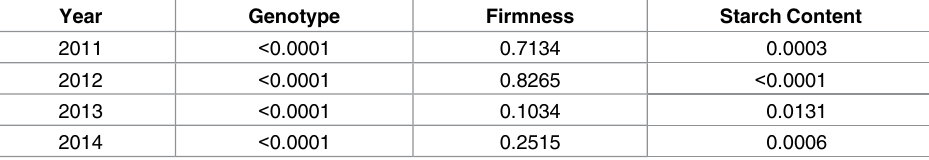
Table 2. Probability ( P) that genotype (progeny), fruit firmness, and fruit starch content had no effect on blue mold lesion diameter 7 days post-inoculation.